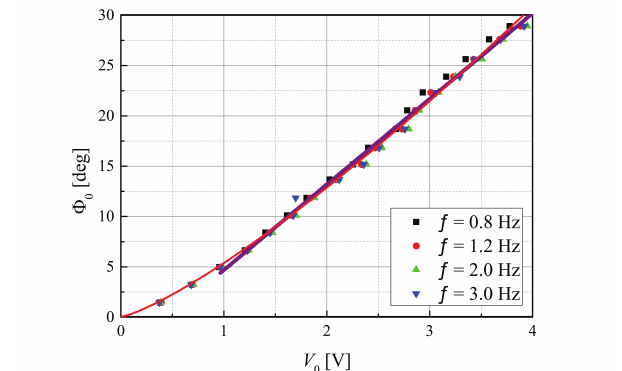
Figure 7. Peak-to-peak bending angle according to the peak-to-peak voltage of the smart textile. Black squares, red circles, green upward-pointing triangles, and blue downward-pointing triangles represent the voltage output of the sensor at the operating frequency of 0.8, 1.2, 2, and 3 Hz, respectively. The red and purple solid lines represent the power-fitted bending angle and linear fitted bending angle within the bending angle range from 5° to 29° according to the output voltage at f = 1.2 Hz, respectively.